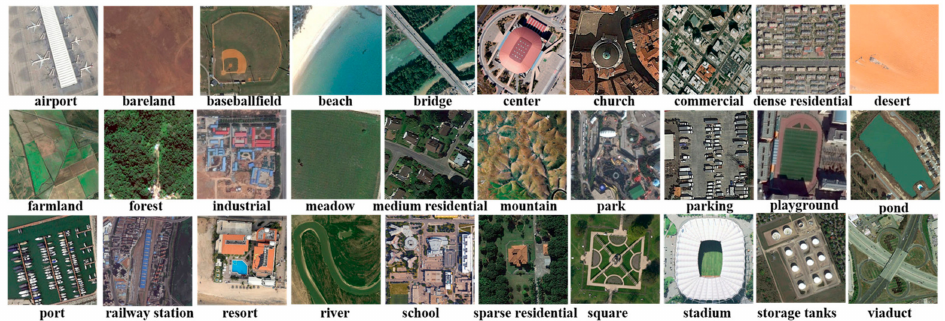
Figure 8. The example images of AID dataset.